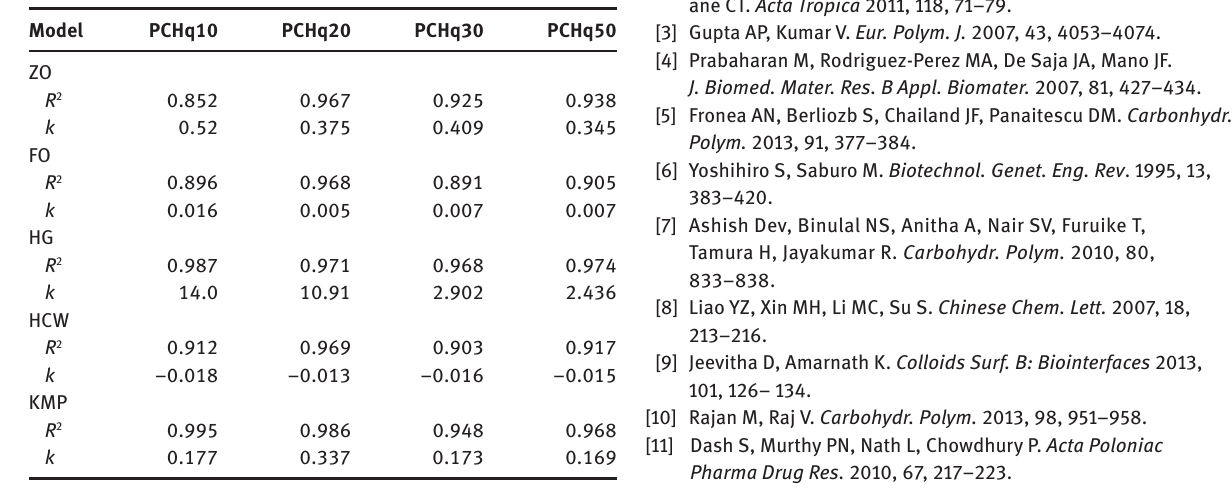
Table 5: Parameters of regression equation reflected Hq released process from the PCHq nanoparticles in pH 2 solution according to different kinetic